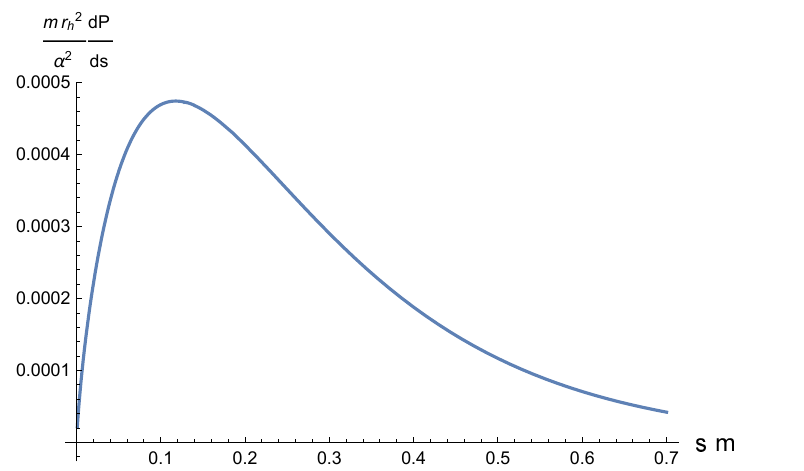
Figure 4 . dP backscatter =ds as a function of the location s . The x -axis gives s in units of the Compton wavelength of the electron 1 =m . The y -axis gives dP backscatter =ds in units of (cid:11) 2